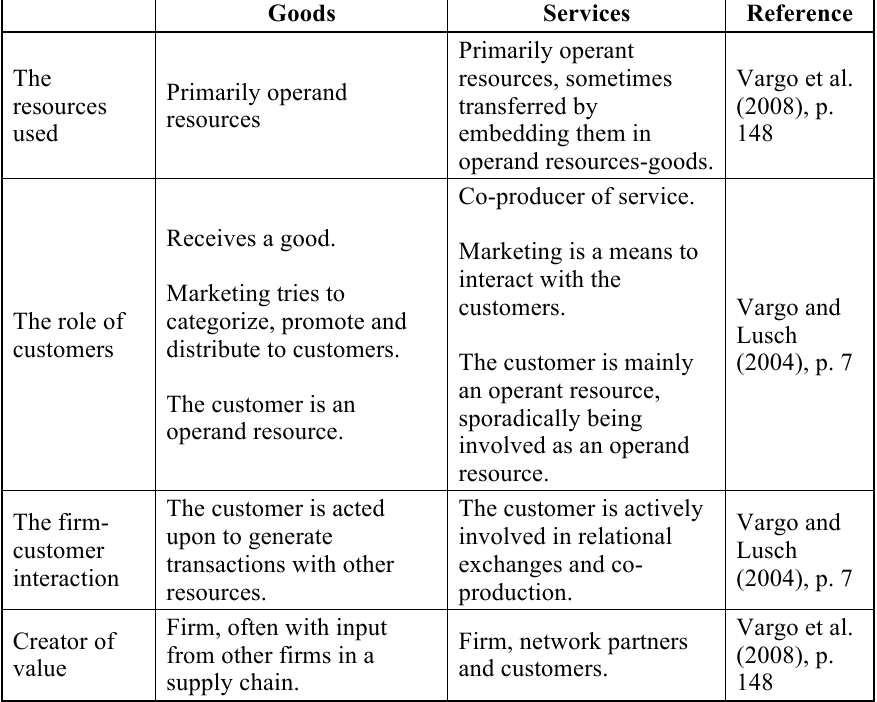
Table 1 : Goods versus services